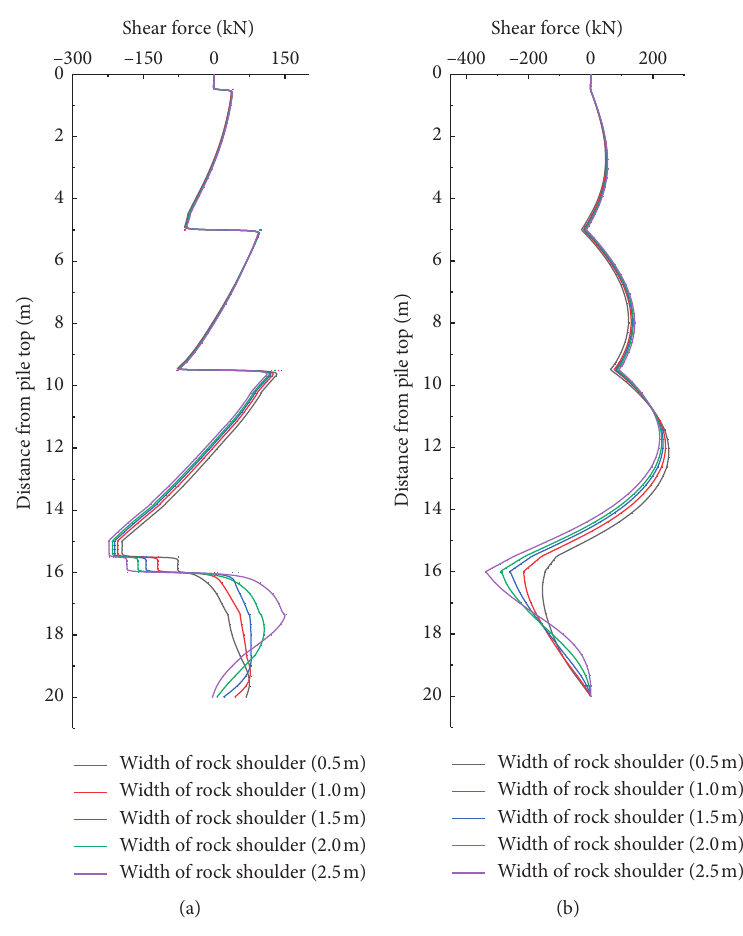
Figure 15: Pile internal force diagram. (a) Shear diagram. (b) Bending moment diagram.